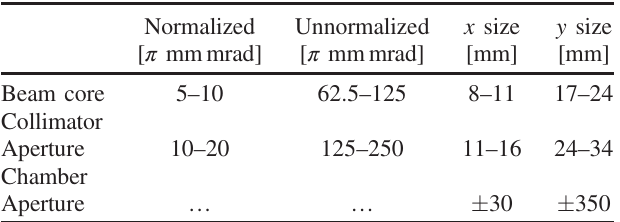
TABLE V. Specifications of beam core emittance and mechani- cal aperture.